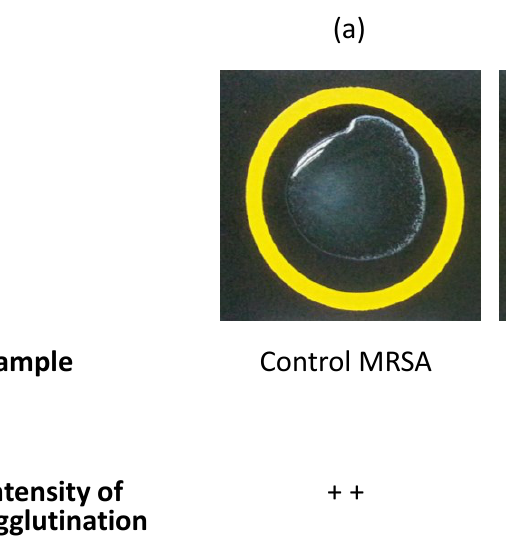
Figure 4. Representative images of PBP2a agglutination on MRSA biofilms showing ( a ) untreated control MRSA; ( b ) MRSA treated with ampicillin (0.05 mg/mL) and ( c ) MRSA treated with F-10 (0.75 mg/mL). Image (b) showed the highest intensity of agglutination followed by (a) and (c). (Interpretation: + + + high, + + moderate, +